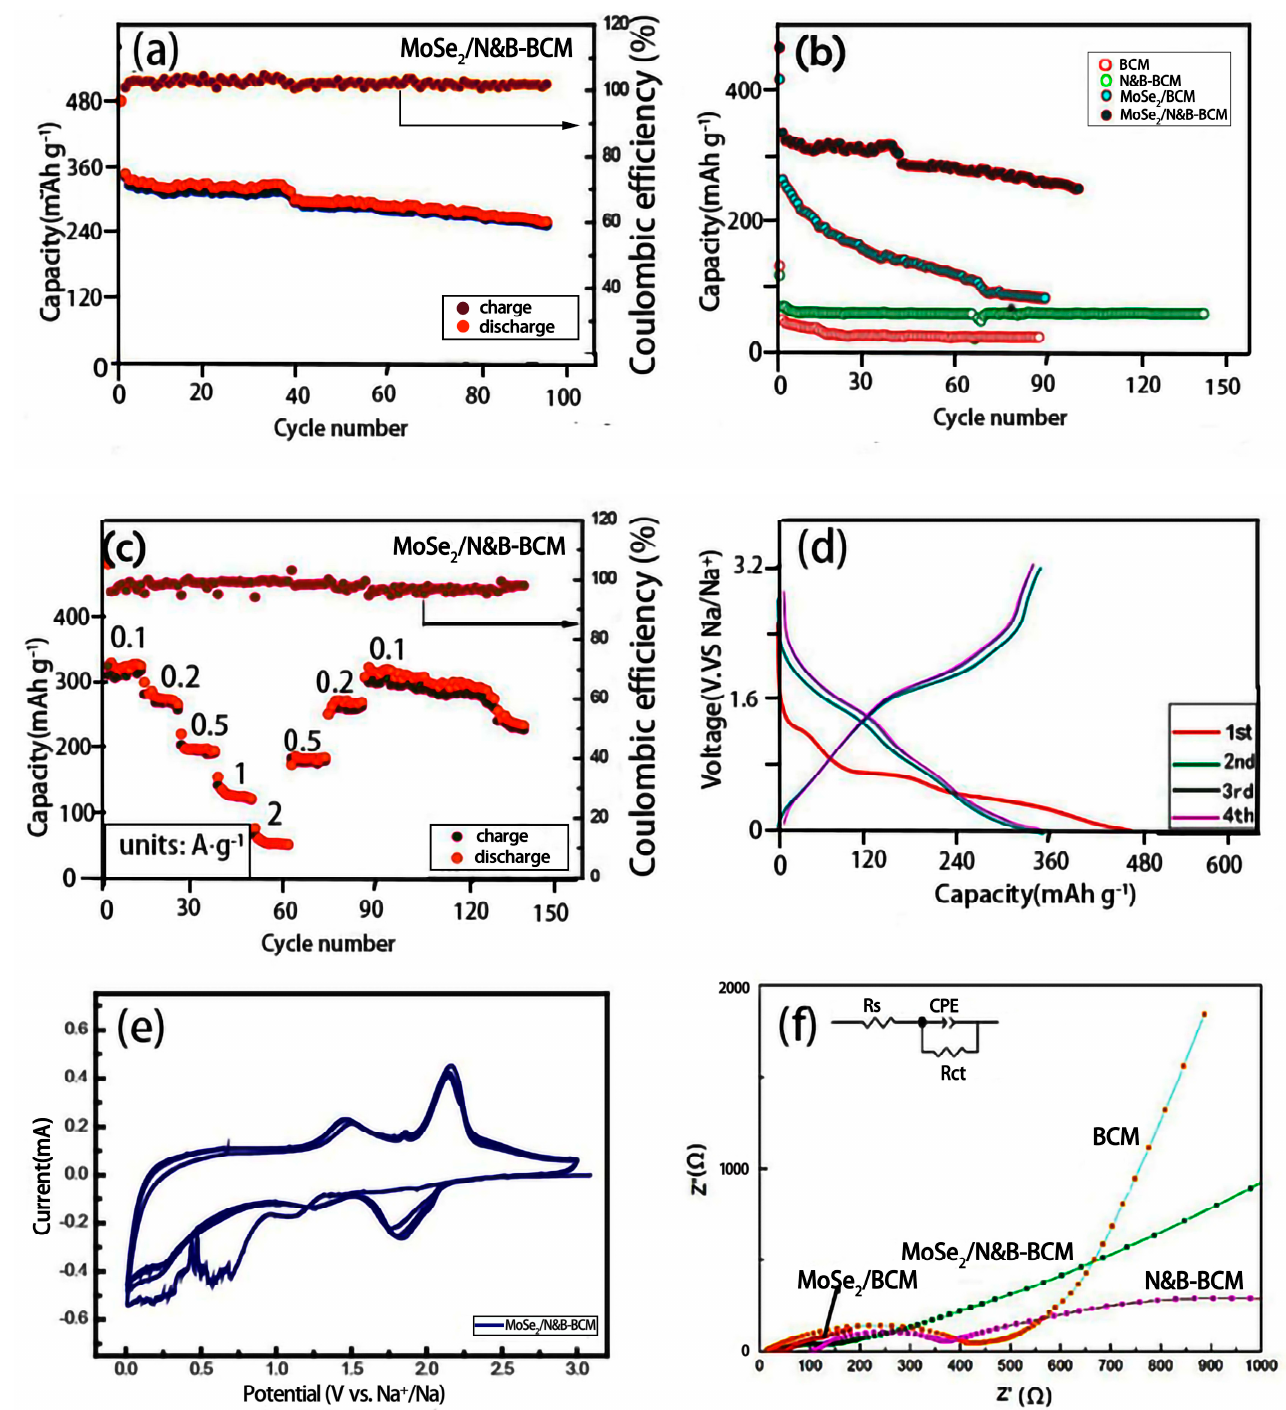
Figure 5. ( a ) MoSe 2 /N&B-BCM cycling performance at 0.5 A · g − 1 . ( b ) BCM, N&B-BCM, MoSe 2 /BCM, and MoSe 2 /N&B-BCM materials’ cycling performances at 0.5 A · g − 1 . ( c ) Rate performance at different rates from 0.1 to 2 A · g − 1 . ( d ) Galvanostatic charge–discharge profiles at a constant rate of 0.1 A · g − 1 . ( e ) CV curves for MoSe 2 /N&B-BCM. ( f ) Electrochemical Impedance Spectroscopy of BCM, N&B- BCM, MoSe 2 /BCM, and MoSe 2 /N&B-BCM.